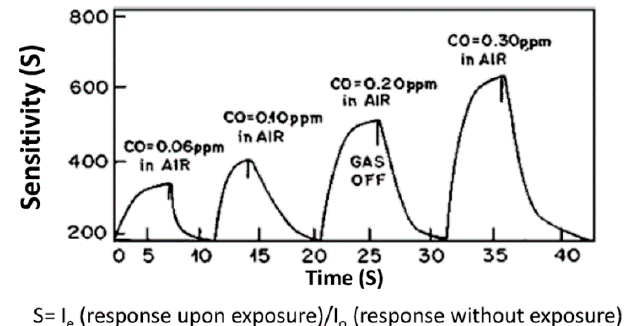
Figure 4. Response of a sensor based on a PANI − Fe:Al (80:20) nanocomposite thin film for CO in the range of 0.06 − 0.3 ppm (reproduced with permission from [58]).